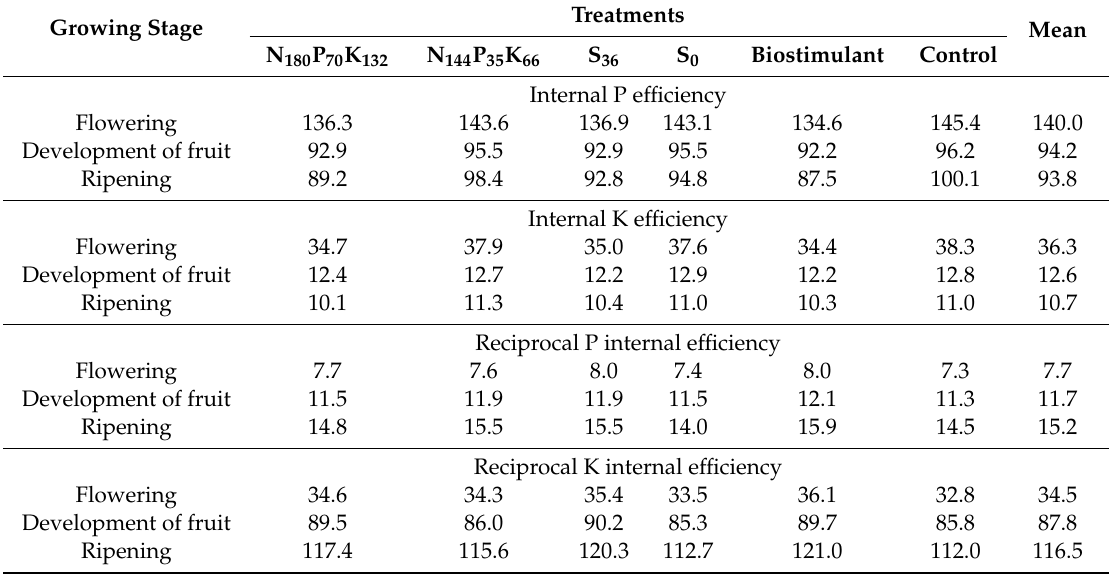
Table 9. Internal e ffi ciency and reciprocal internal e ffi ciency P and K, mean from 2011–2013 (kg ha − 1